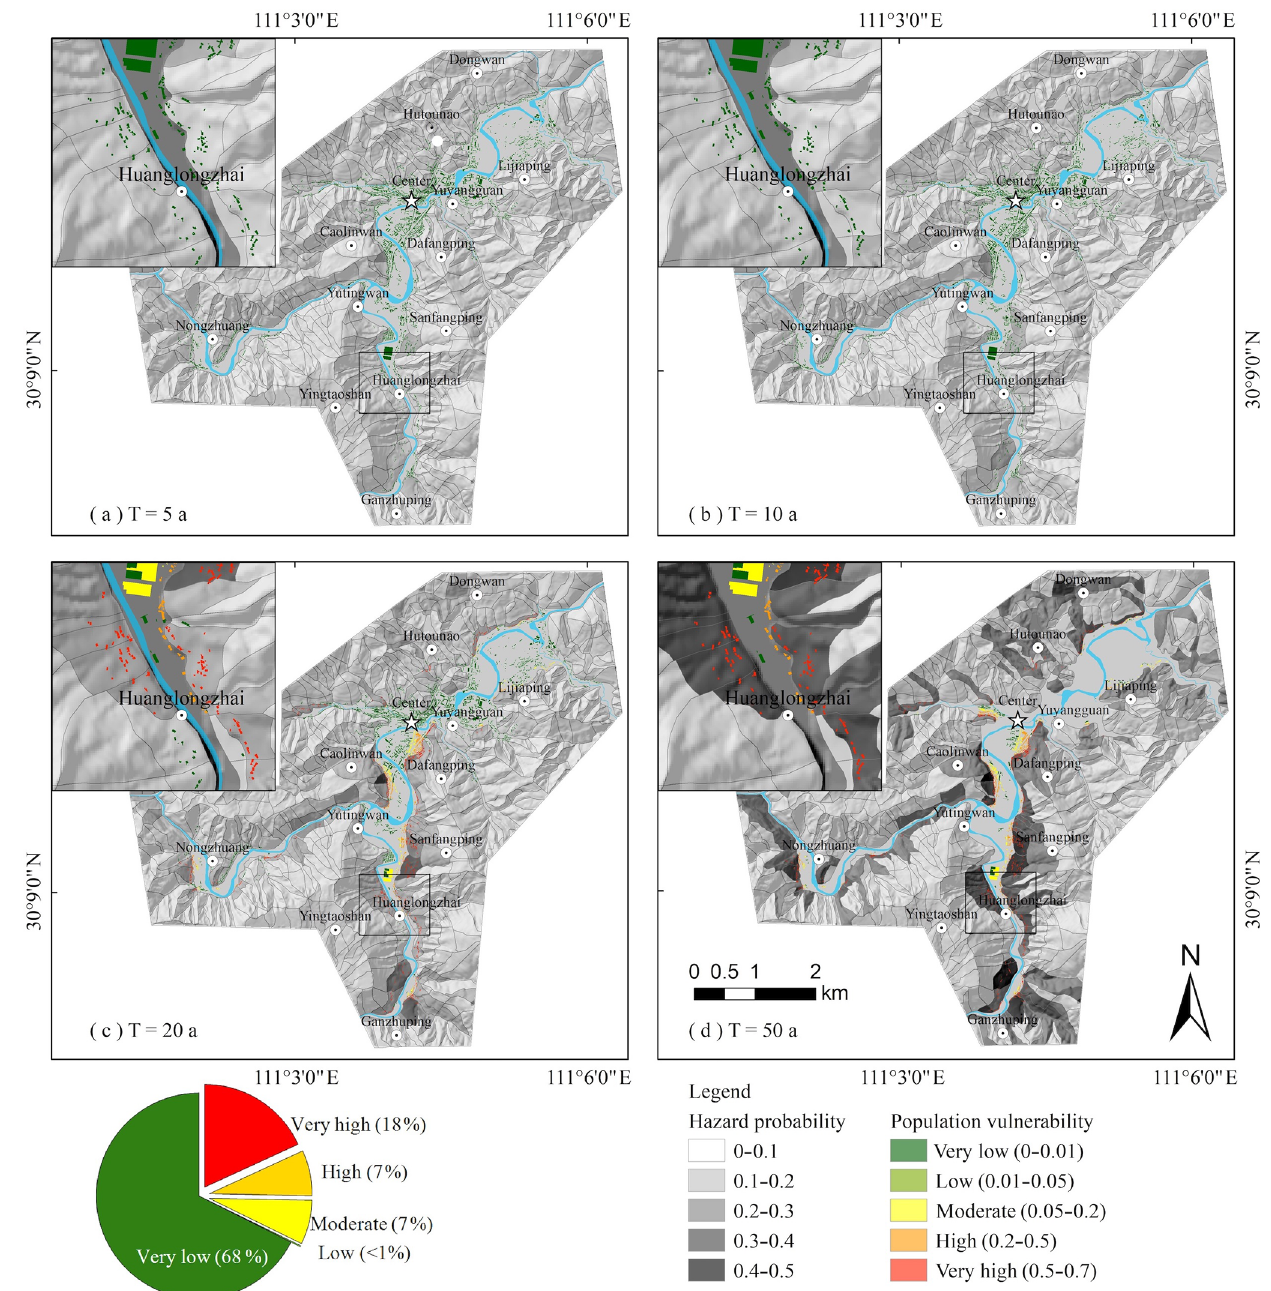
Figure 14. Population exposed to landslides and vulnerability distribution map for four return periods (5, 10, 20, and 50 years) and size scenarios of landslide volume equal to or greater than 50000m 3